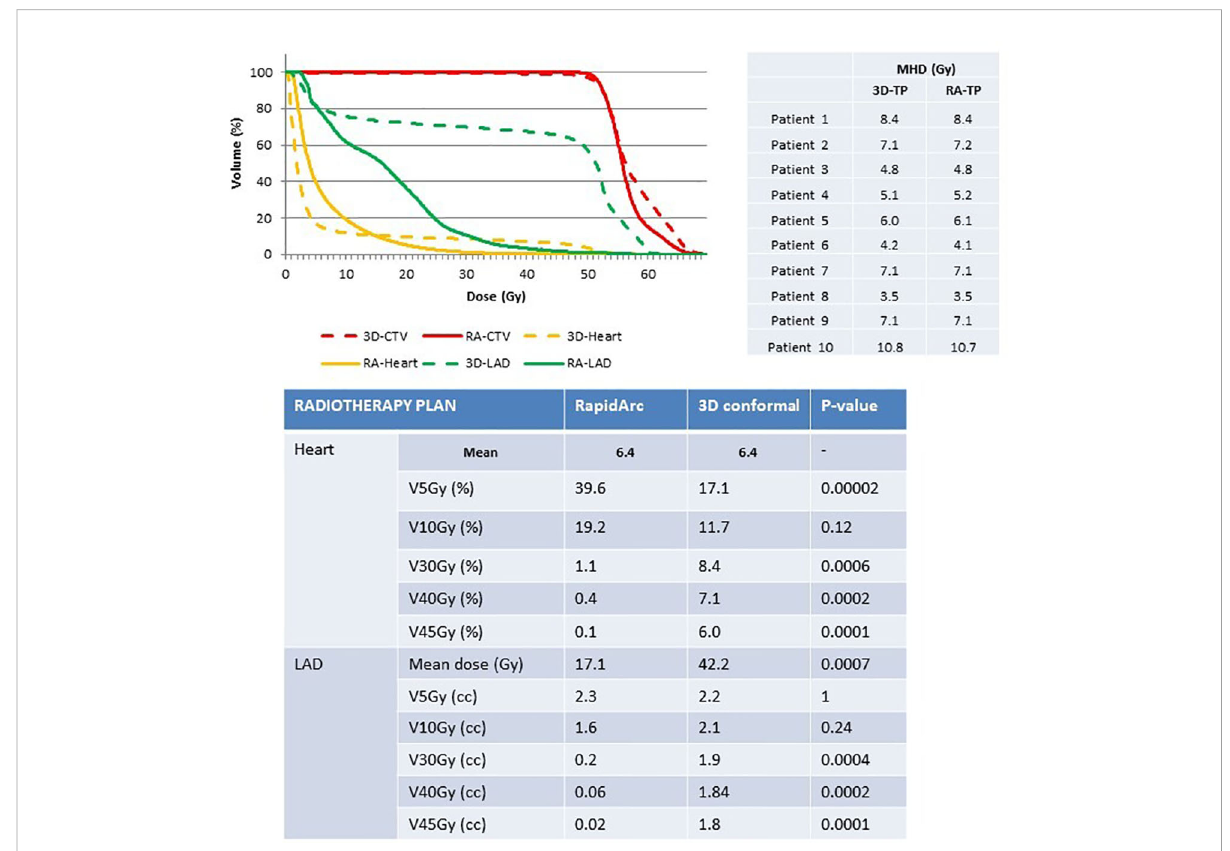
FIGURE 3 Comparison of heart and LAD exposure in the radiotherapy plans (3D-conformal versus RapidArc-based IMRT) for similar intra-patient MHD. 3D, 3D-conformal; RA, RapidArc; CTV, clinical target volume; LAD, left anterior descending coronary artery; TP, treatment